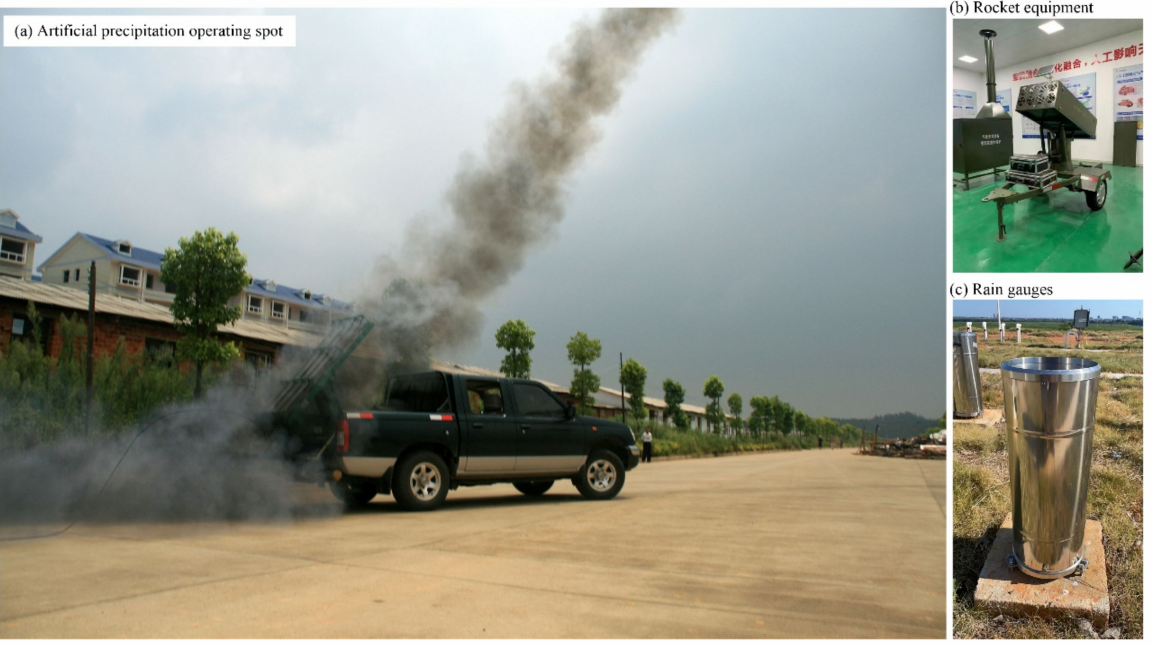
Figure 2. Selected photographs of artificial precipitation enhancement. ( a ) Operating spot; ( b ) rocket equipment; and ( c ) rain gauges for